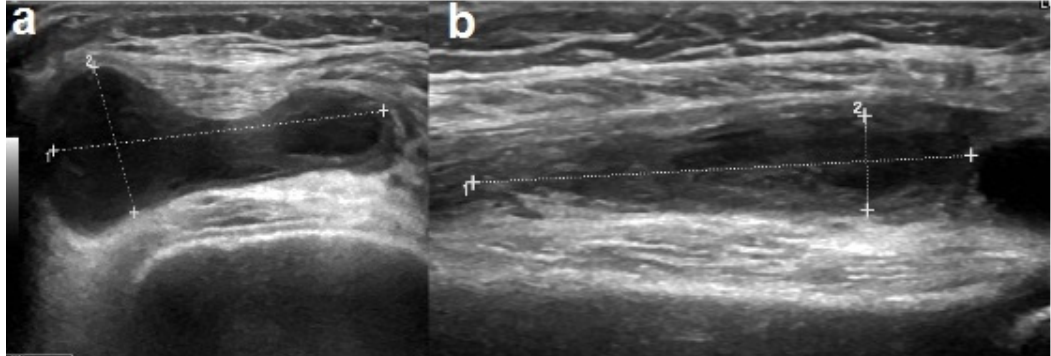
Figure 3. Ultrasound performed after a worsening of the right knee swelling showed increase in synovial thickening ( a ) and organized joint corpuscular effusion ( b ).